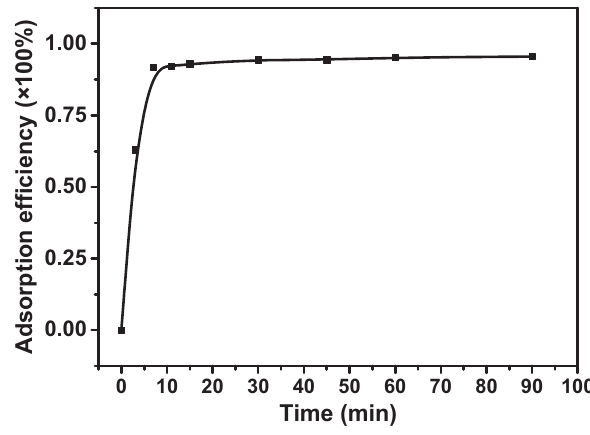
Figure 4: The optimization of adsorption time by the adsorption e